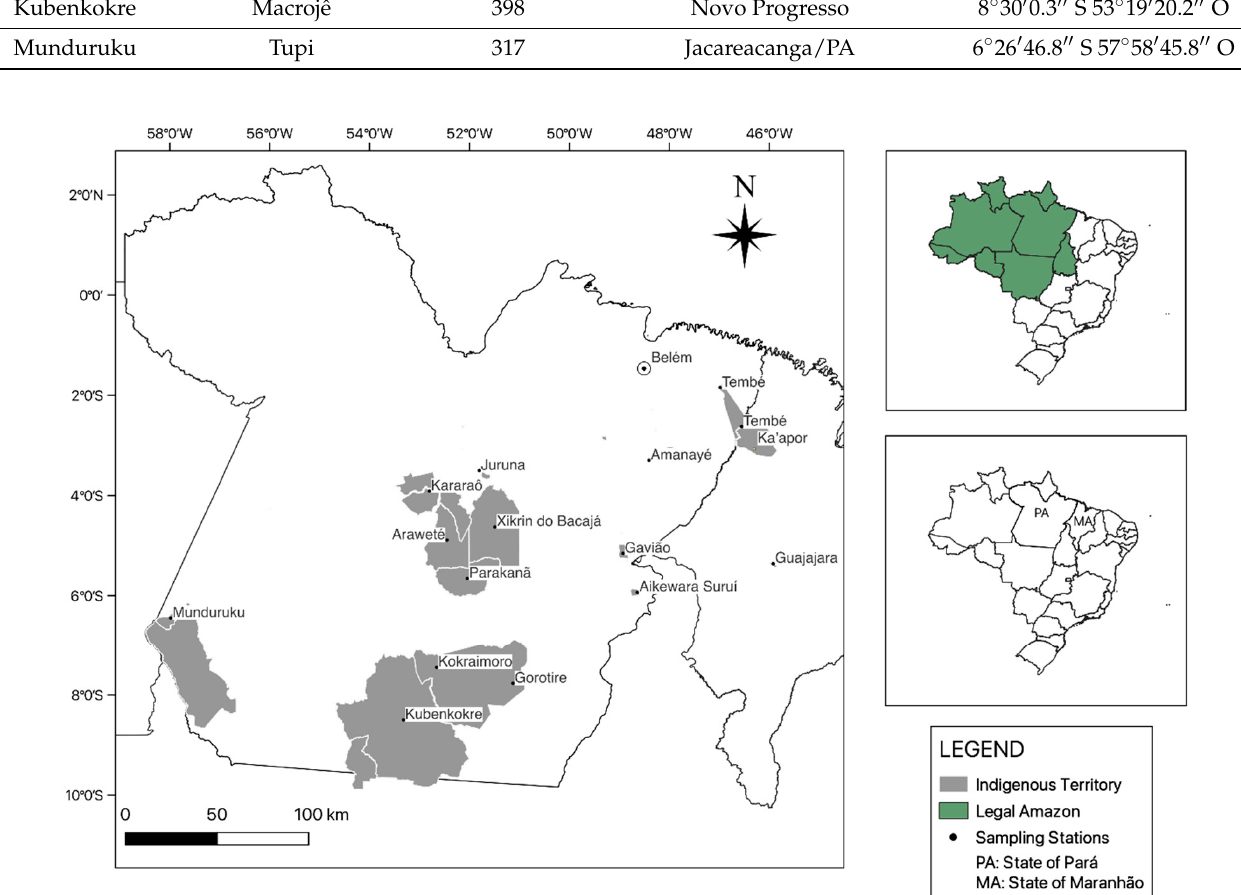
Figure 1. Geographic location of the studied Indigenous territories.